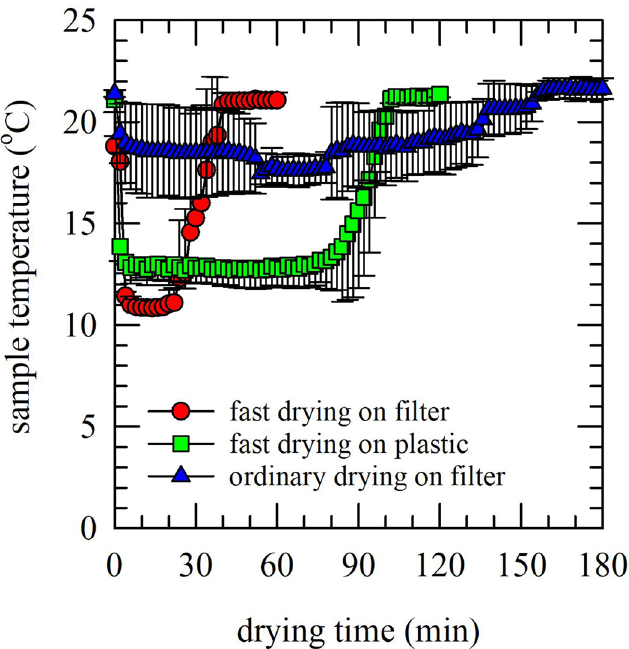
Figure 2. Drying kinetics of saliva samples deposited on different surfaces and exposed to different drying conditions, as determined by following the sample temperature versus the drying time. Saliva was dried fast under a stream of dry air, on filters (red circles) or on a plastic surface (green squares). In addition, filters with saliva were exposed to ordinary air drying (blue triangles). Pooled saliva was used from three different donors. Measurements were performed in triplicate using saliva aliquots, and mean values ± standard deviations are presented.